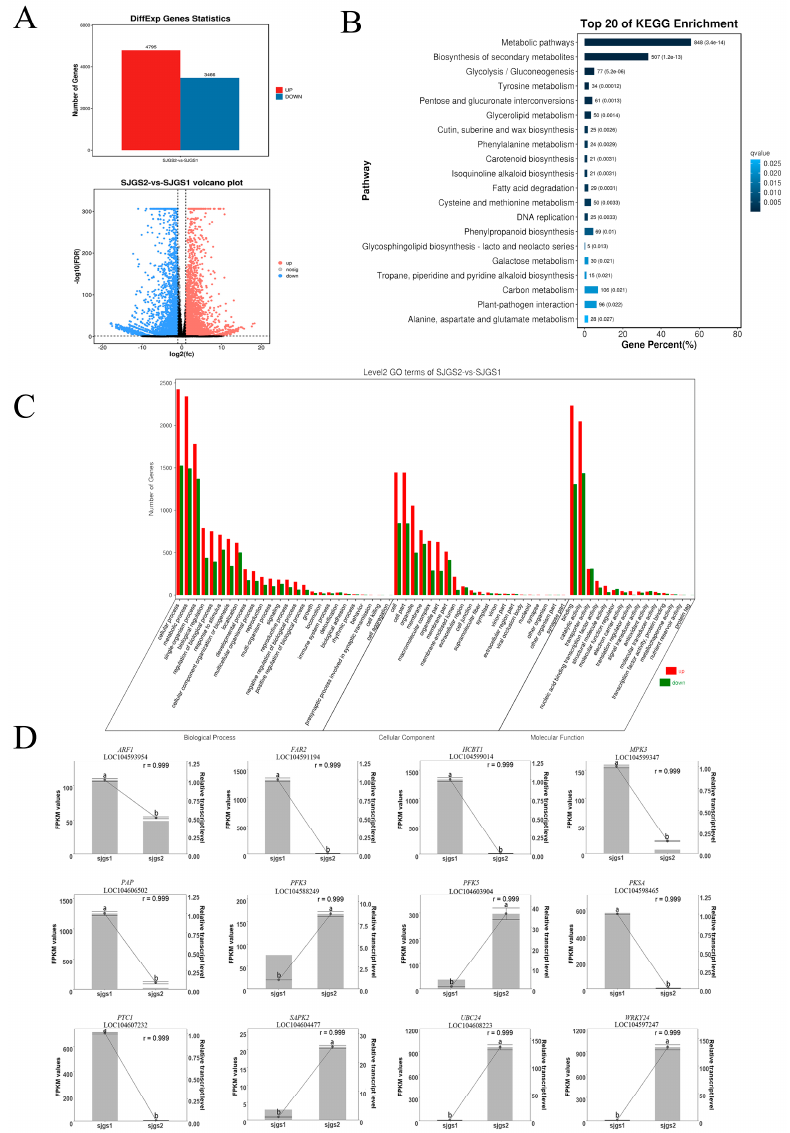
Figure 3. Transcriptome analysis of anthers during the critical period of abortion and after abortion in ‘Sijinggangshan’. ( A ) Histogram of differential genes and volcano diagram. ( B ) The top 20 KEGG pathways of differential genes. ( C ) Go classification map of differential genes. SJGS1 anthers during the critical period of abortion. SJGS2 anthers after completion of abortion. ( D ) qRT-PCR analysis of ARF1 auxin response factor 1 of 12 differential genes. FAR2 fatty acylCoA reductase 2, HCBT1 omega-hydroxypalmitate Oferuloyl transferase, MPK3 mitogen-activated protein kinase 3, PAP plastid-lipid-associated protein, PFK3 ATP-dependent 6-phosphofructokinase 3, PFK5 ATP-dependent 6-phosphofructokinase 3, PKSA type III polyketide synthase A, PTC1 PHD finger protein PERSISTENT TAPETAL CELL 1, SAPK 2 serine/threonine-protein kinase 2, UBC24 probable ubiquitin-conjugating enzyme E2 24, WRKY24 WRKY transcription factor 24. Black bars represent the mean FPKM values. Black dots represent the mean qRT–PCR values. Error bars indicate the SD for three biological replicates based on qRT–PCR, and shared letters indicate no statistically significant difference between the means ( p > 0.05) as determined by ANOVA. The correlation coefficient was calculated by R with mean FPKM values and relative transcript levels generated by qRT–PCR.